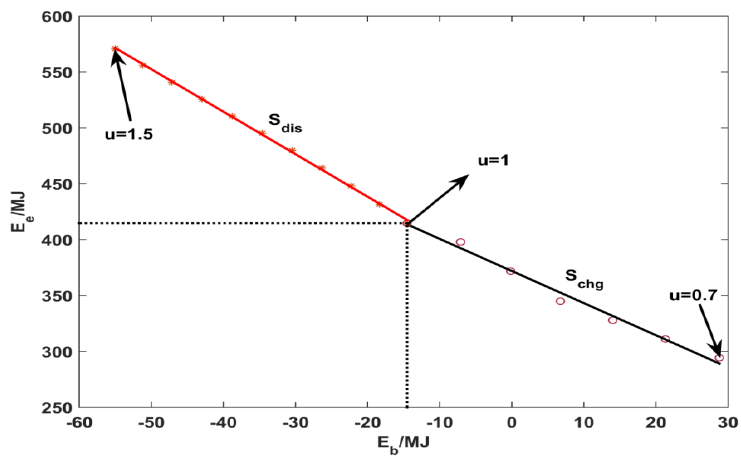
Figure 6. Equivalent relationship between fuel energy and electric energy.